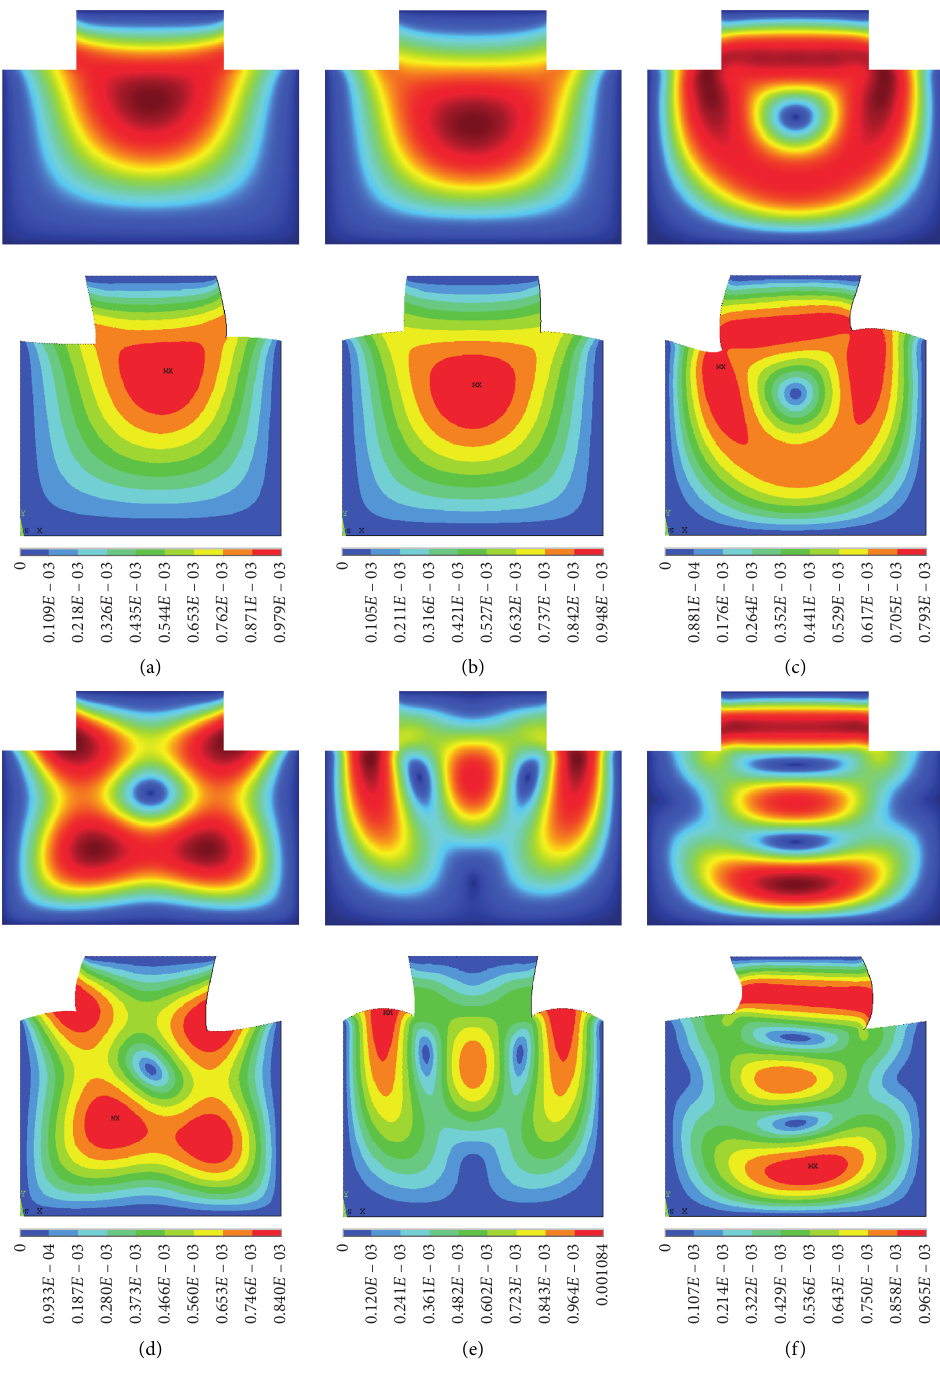
Figure 11: The first six mode shapes for the square plate with double corner cutouts. (a) The first mode; (b) the second mode; (c) the third mode; (d) the fourth mode; (e) the fifth mode; (f) the sixth mode. Upper: the present results; lower: the ANSYS